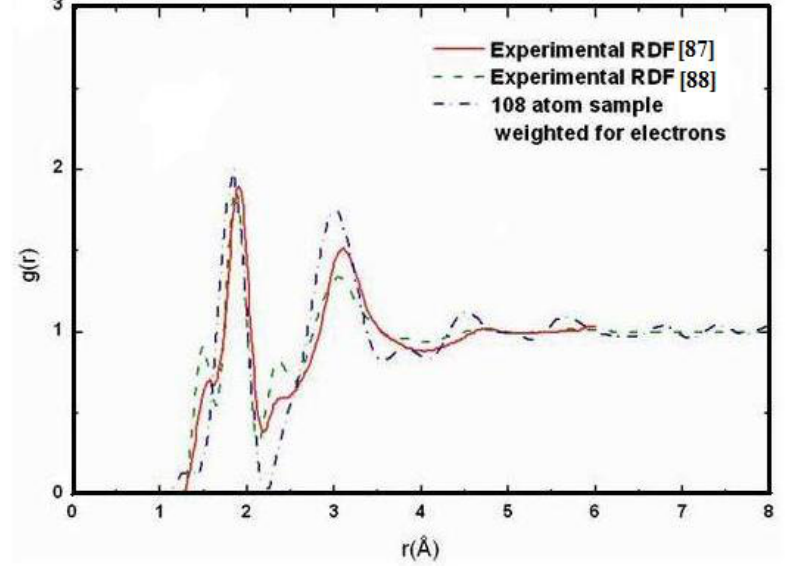
Figure 23. Comparison of the total RDF for the 108-atom sample, weighted for electrons, with the two experimental results